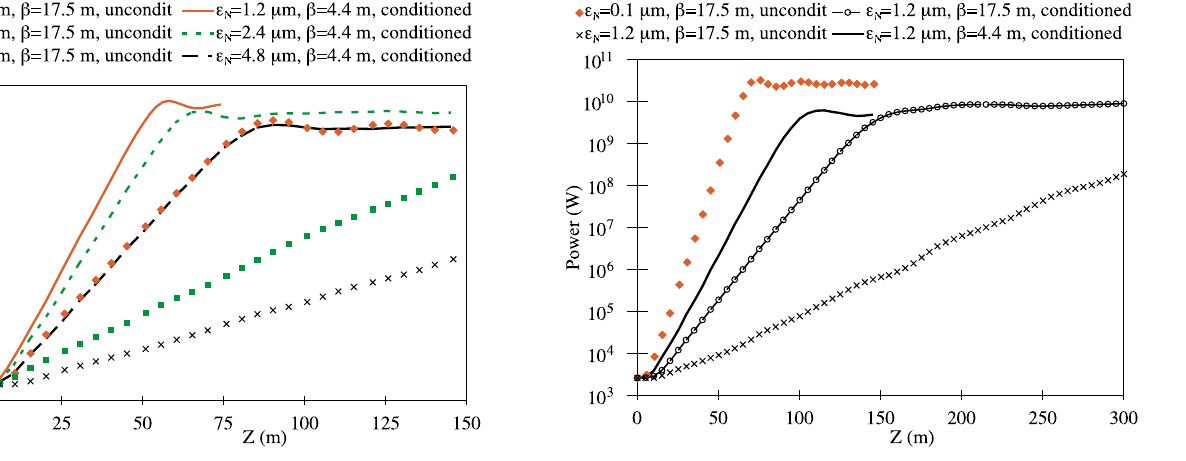
beams.FIG. 5. (Color) Radiation power as a function of undulator length for a ‘‘Greenfield’’ FEL at 12 GeV. Different beta functions and emittances are shown, with conditioned and unconditioned